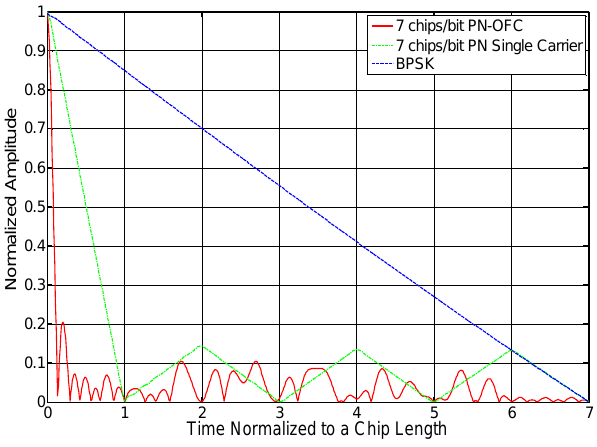
Figure 9. Time autocorrelations of a seven chip PN-OFC, seven chip PN (Barker code), and single-frequency-chip (BPSK) signal having identical time lengths. Only half of the autocorrelation is shown due to symmetry. The peak correlation amplitude is the same, but the main compressed pulse width is inversely proportional to